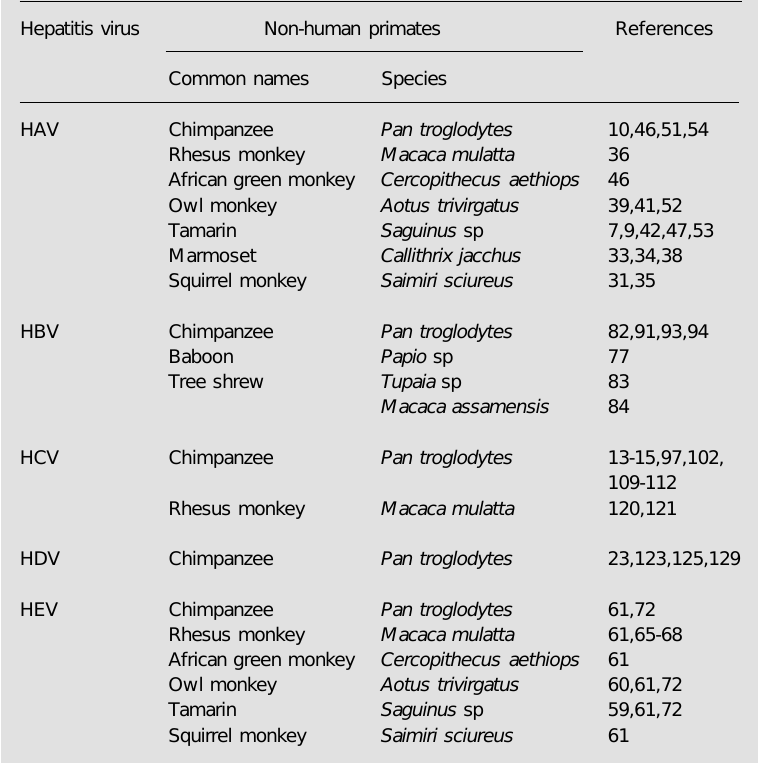
Table 1 - Non-human primates used as animal models for studies on hepatitis virus